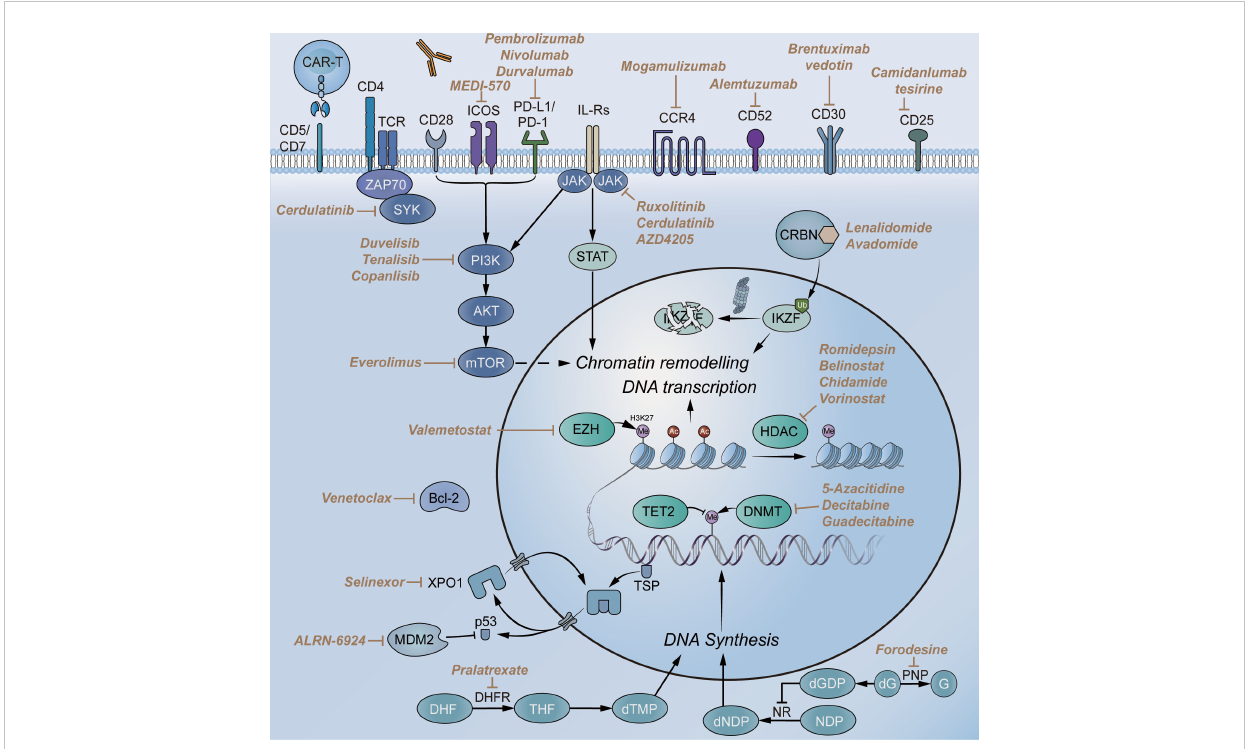
FIGURE 4 Selected novel agents for T-FHCL. Abbreviations: CD, cluster of differentiation; TCR, T-cell receptor; CCR4, chemokine receptor 4; PD-1, programmed death receptor 1; PD-L1, programmed cell death-ligand 1; PI3K, phosphoinositide 3-kinase; JAK, Janus kinase; SYK, spleen tyrosine kinase; mTOR, mammalian target of rapamycin; STAT, signal transducer and activator of transcription; CRBN, cereblon; IKZF, Ikaros zinc fi nger; HDAC, histone deacetylase; DNMT, DNA methyltransferase; EZH, enhancer of zeste homolog; DHFR, dihydrofolate reductase; NR, ribonucleotide reductase; G, guanine; dG, deoxyguanosine; dNDP, deoxyribonucleoside diphosphate; PNP, purine nucleoside phosphorylase; TSP, tumor suppression protein; MDM2, murine double minute 2; XPO1, exportin